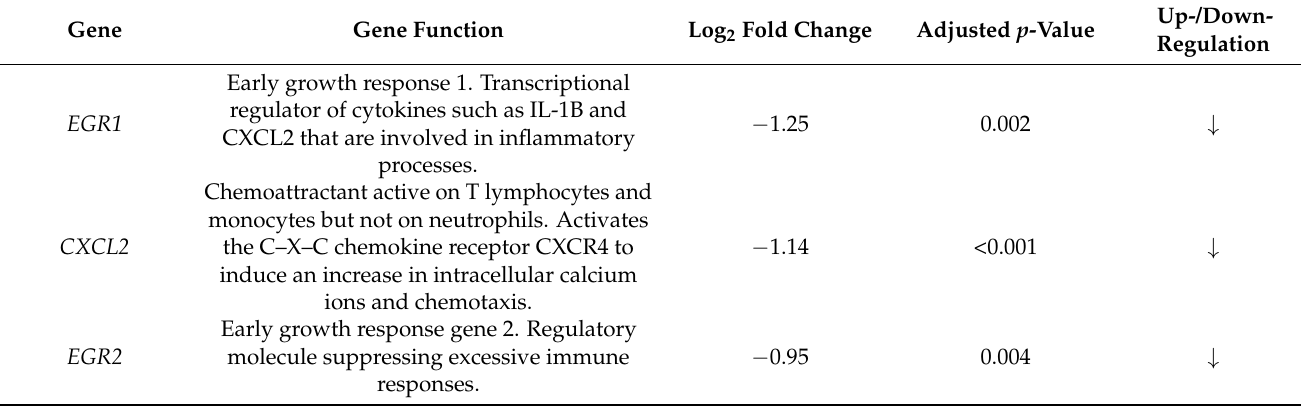
Table 4. Differentially expressed cytokine-related transcripts. AV3 cells incubated with enterovirus strains obtained from cases of autoimmune thyroid disorders vs. AV3 cells incubated with a virus-free medium from controls without evidence of thyroid